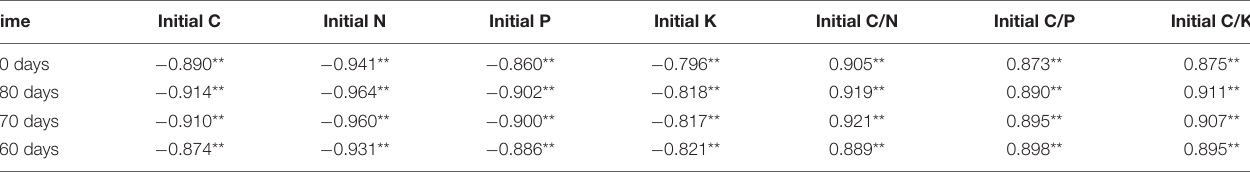
Correlation coefficients of Pearson correlation are shown (n = 20), **P < 0.01. TABLE 5 | Pearson correlation analysis between the percentage of remaining mass and enzyme activity of surface soil (10 cm) in the dry season. Litter Urease Leaf